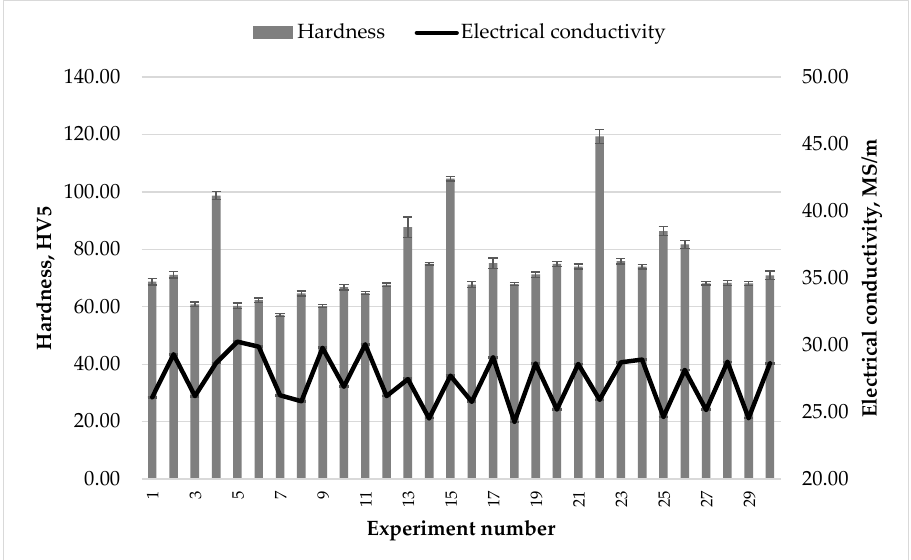
Figure 1. The mean values and standard deviations of the measured results for hardness and electrical conductivity of the flat samples.